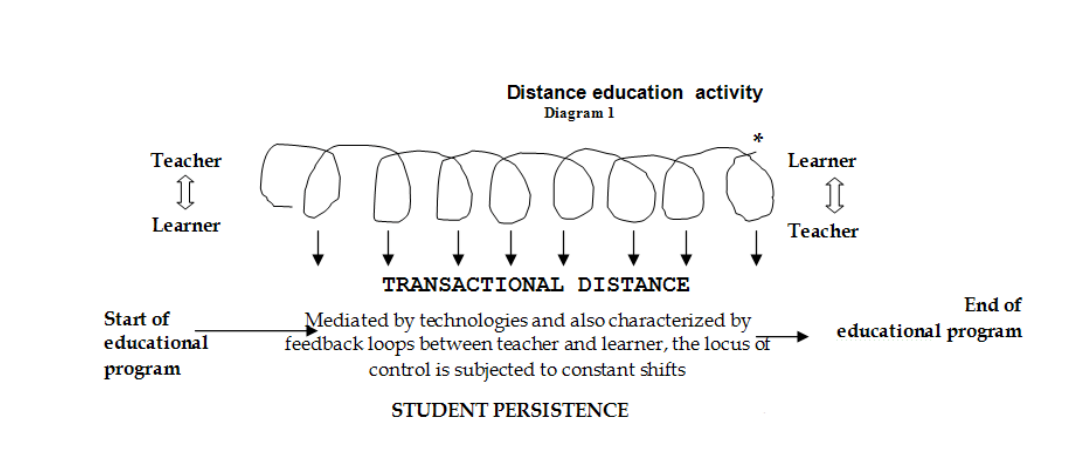
Figure 1. Distance education activity